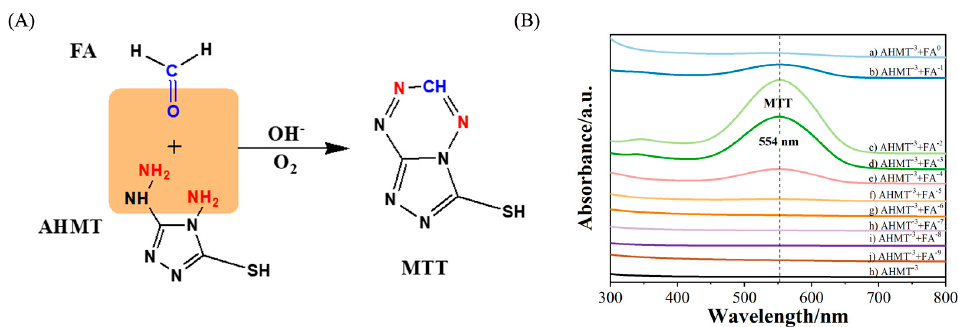
Figure 3. ( A ) Derivative reaction of formaldehyde (FA) and 4-amino-3-hydrazino-5-mercapto-1,2,4-triazole (AHMT) under alkaline conditions. ( B ) UV-vis absorption spectra of different concentrations of FA after reaction with AHMT. ( a – j ) FA (1.44, 1.44 × 10 − 1 , 1.44 × 10 − 2 , 1.44 × 10 − 3 , 1.44 × 10 − 4 , 1.44 × 10 − 5 , 1.44 × 10 − 6 , 1.44 × 10 − 7 , 1.44 × 10 − 8 , and 1.44 × 10 − 9 M) + AHMT (3.34 × 10 − 3 M); ( h ) AHMT (3.34 × 10 − 3 M).